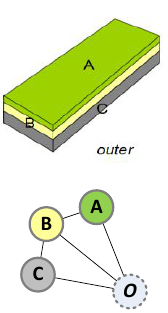
Figure 5. Simultaneous spatial and topological representation of landforms The topological adjacency relationships between 3D AbstractStructure ( StructureBoundary , i.e. a shared face) are transformed to